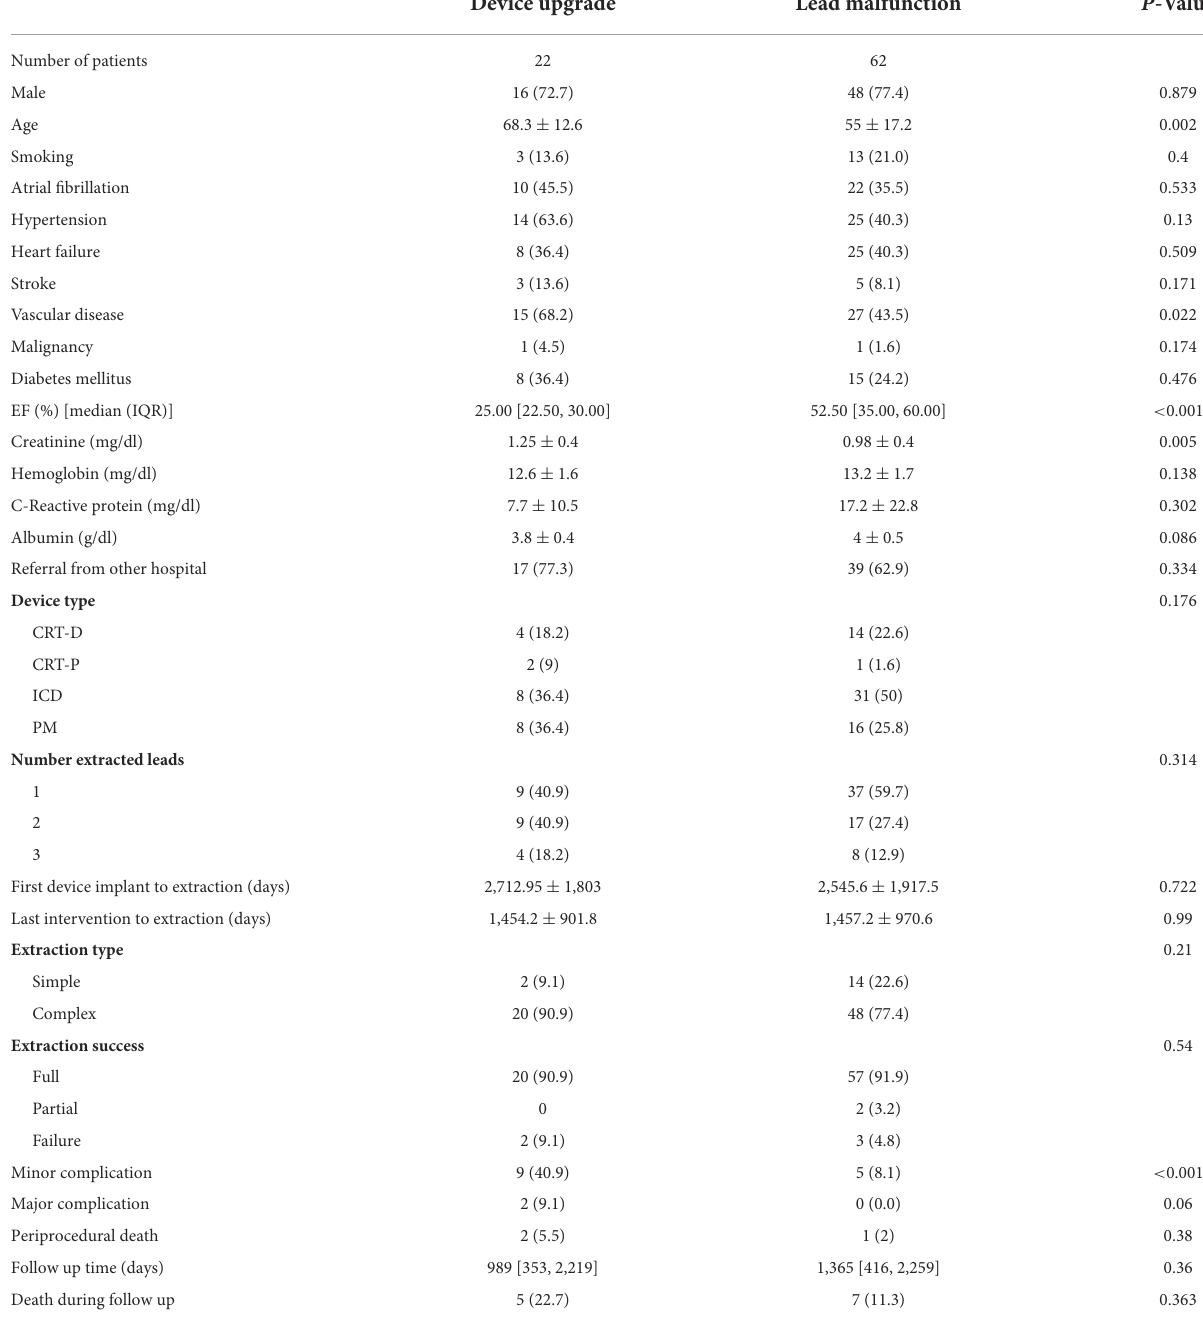
TABLE 2 Comparison of TLE due to lead malfunction or device upgrade in the setting of an occluded vein. Device